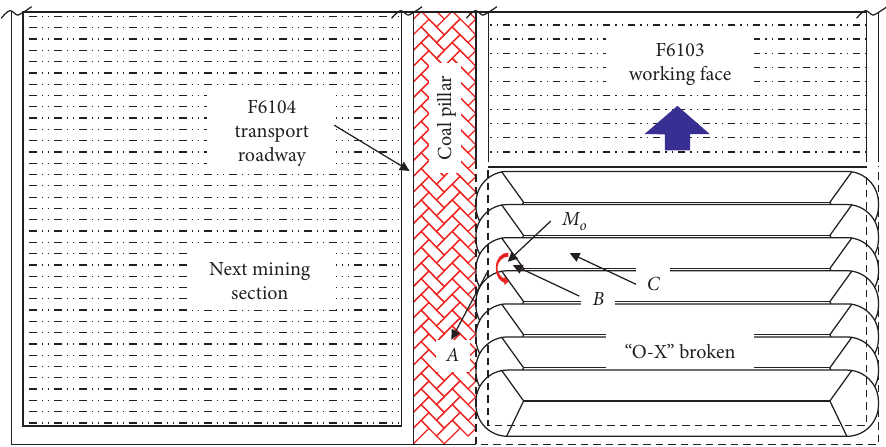
Figure 3: Plane relationship between the roadway and the overlying strata after